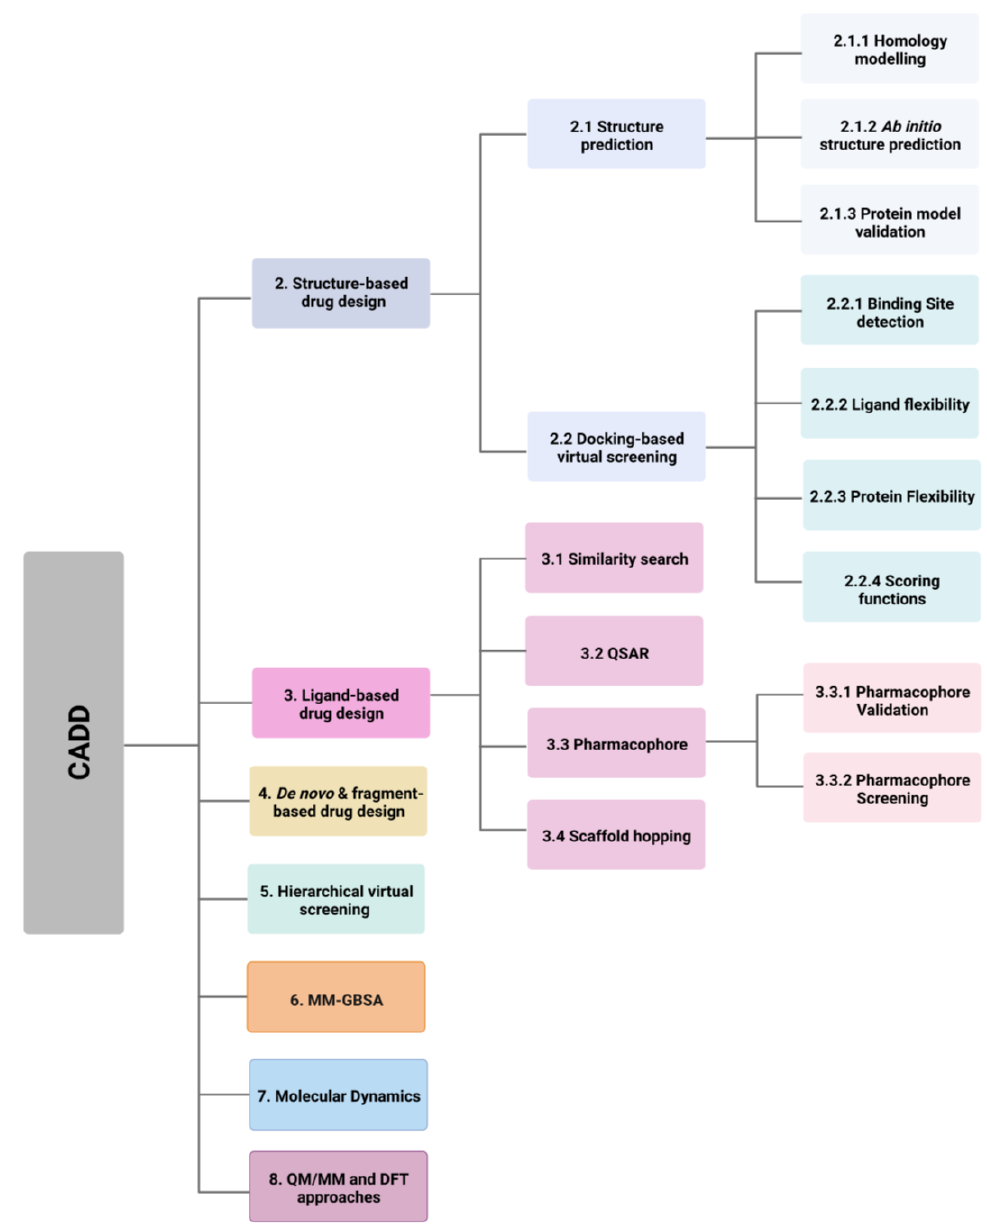
Figure 2. Various in silico techniques used in the drug design and discovery process discussed in this review. (Abbreviations: CADD: computer-aided drug design; DFT: density functional theory; MM: molecular mechanical; MM-GBSA: molecular mechanics with generalised Born and surface area; QM: quantum mechanical; QSAR: quantitative structure activity relationship).